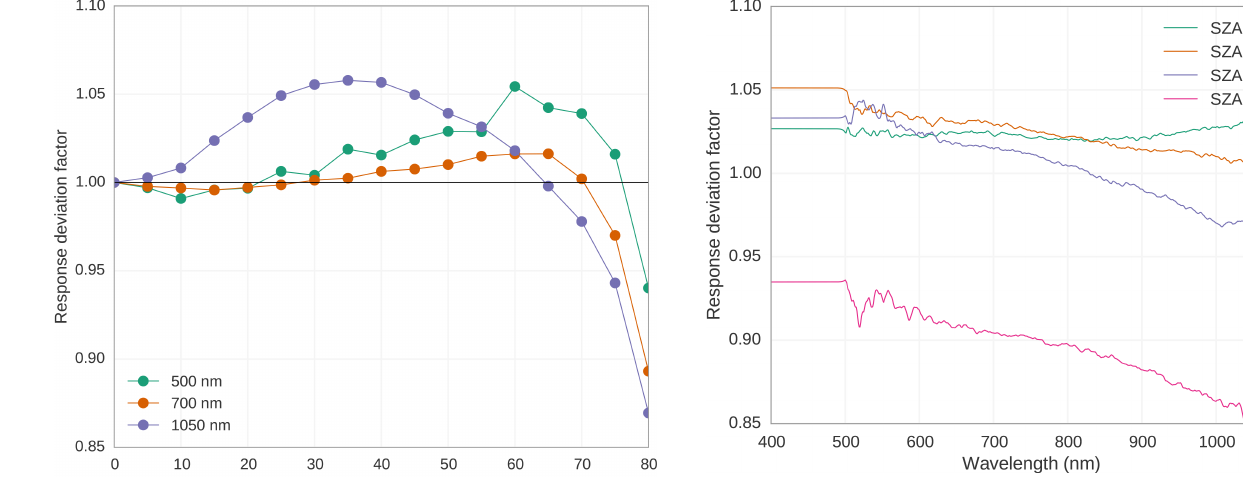
Figure 8. Response of the light collector as a function of the an- gle for different wavelengths. Values are relative to the ideal cosine response and normalized at 0 ◦ .